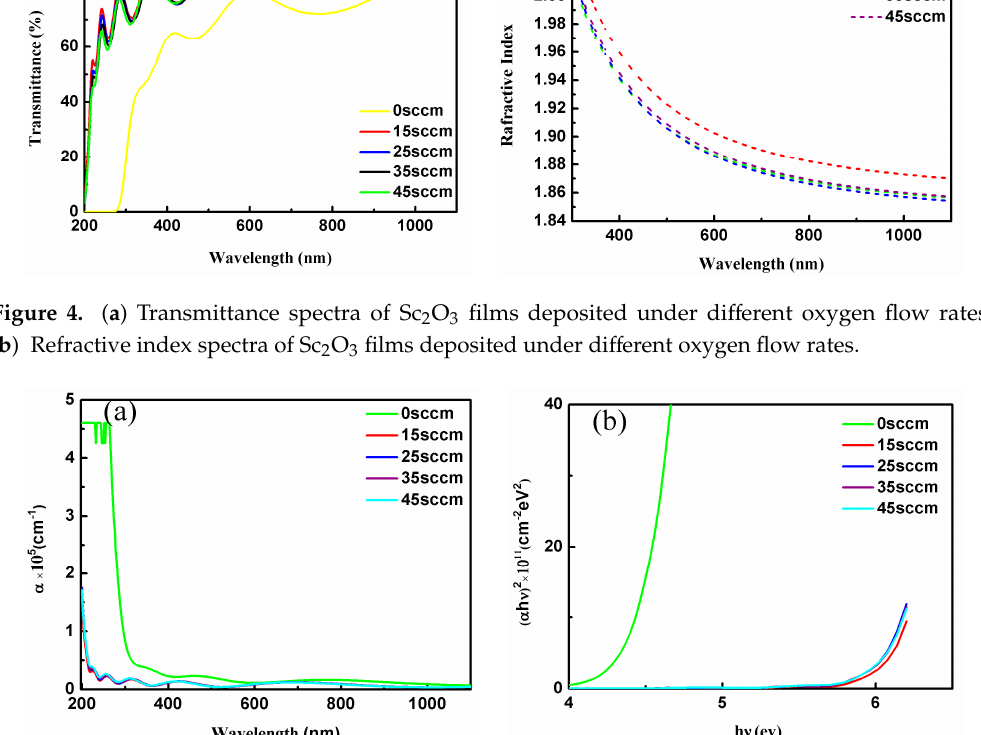
Figure 4. ( a ) Transmittance spectra of Sc 2 O 3 films deposited under different oxygen flow rates; ( b ) Refractive index spectra of Sc 2 O 3 films deposited under different oxygen flow rates.